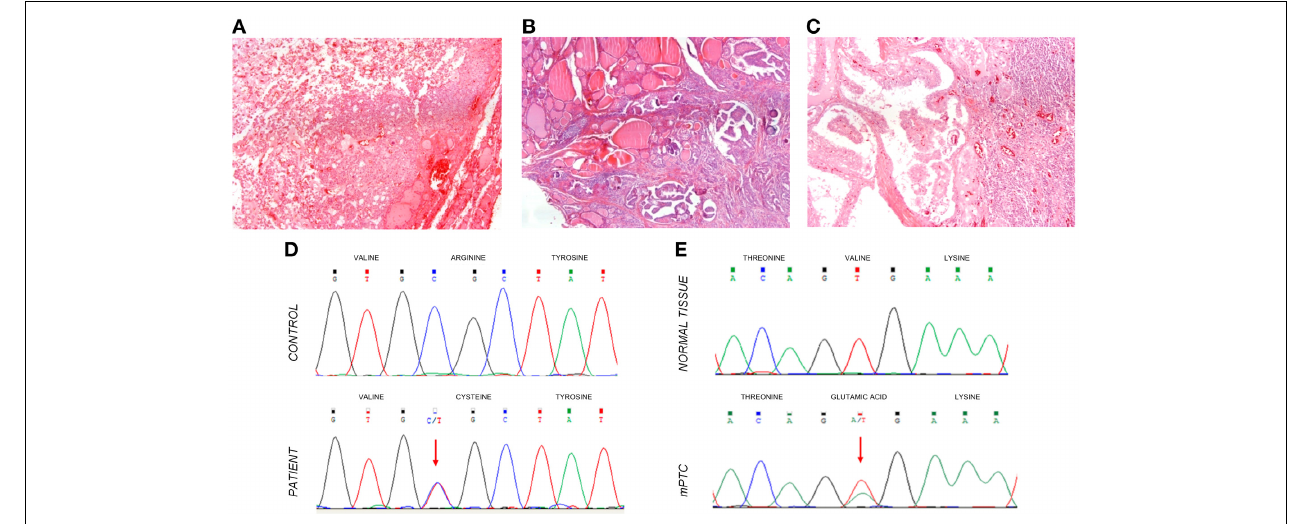
FIGURE 2 | Haematoxylin-eosin stained histological sections of a follicular adenoma, initially detected in the patient (A); a papillary microcarcinoma (B); and metastasis of the mPTC in a lymph node following the cervical drainage (C). The total magnification of the sections is 200X. Molecular genotyping of the samples detected the